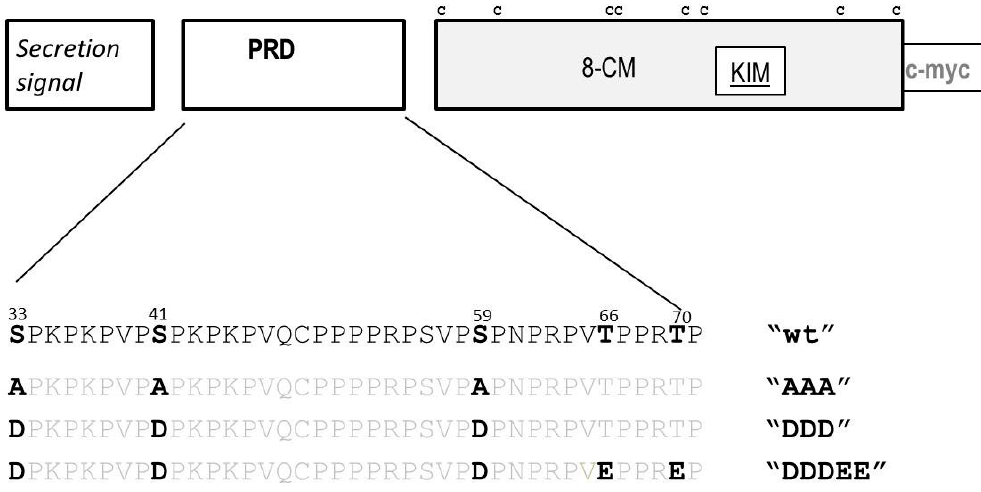
Figure 1. AZI1 primary protein structure. ( Top ): The protein sequence of AZI1 is shown with putative secretion signal in italics, proline rich domain (PRD) in bold and cysteine residues (C) and putative MAP kinase interaction motif (KIM) underlined; ( Middle ): A cartoon of the protein motifs, with position of cysteine residues within the 8-cysteine-motif (8-CM) indicated); ( Bottom ): The PRD is shown in detail, with all five putative MAPK phosphorylation sites (serine, S; threonine, T) highlighted. Dephosphomimetic (AAA) and phosphomimetic AZI1 variants (DDD, DDDEE), carrying amino acid substitutions to alanine (A), aspartate (D) or glutamate (E) are displayed below the AZI1 wild type (wt) sequence. All constructs used carry a C-terminal c-myc tag.